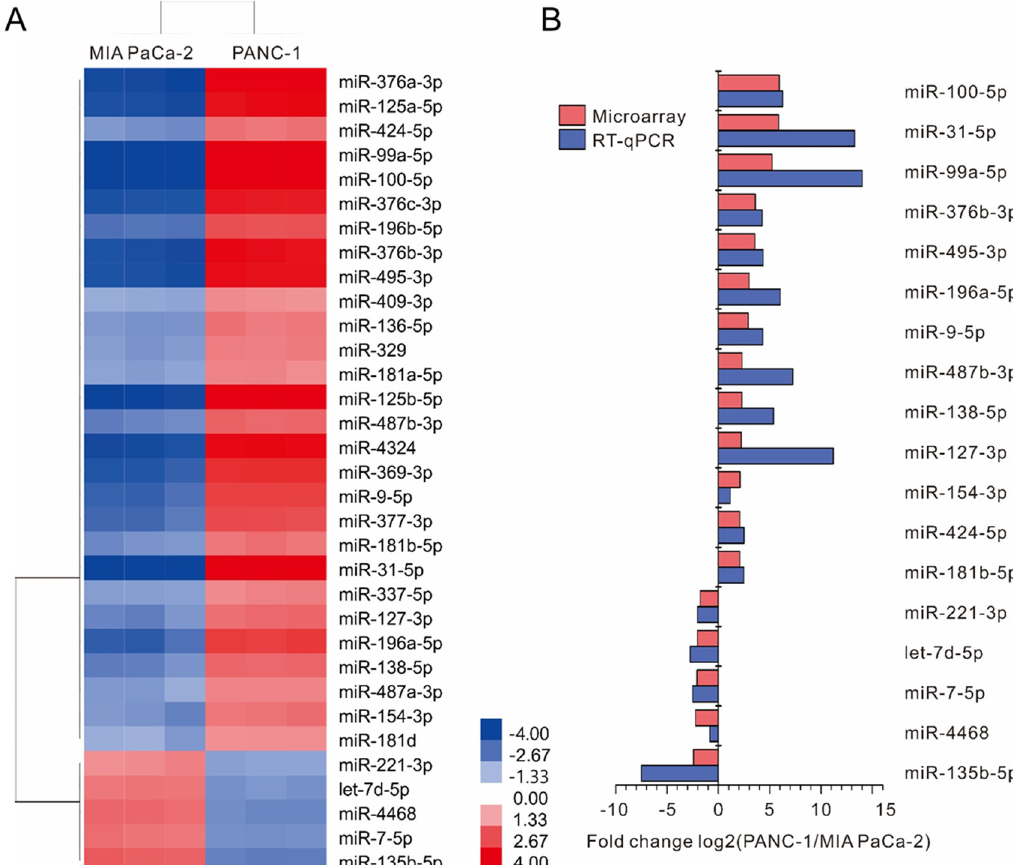
Figure 1. miRNA expression profile in MIA PaCa-2 and PANC-1 cell lines. ( A ) Hierarchical clustering result of 33 di ff erentially expressed miRNAs. Each column corresponds to a single microarray, whereas each row indicates the expression profile of a single gene. The cluster analysis shows a clear separation between the two groups of samples. Colored bars indicate the range of fold change. ( B ) Validation of miRNA microarray data was done for 18 di ff erentially expressed miRNAs using real-time RT-PCR. Data represent the log2-transformed fold change of expression between two pancreas ductal adenocarcinoma cell lines. U6 was used as an internal miRNA control. The qPCR values were displayed in blue and the array results in red.